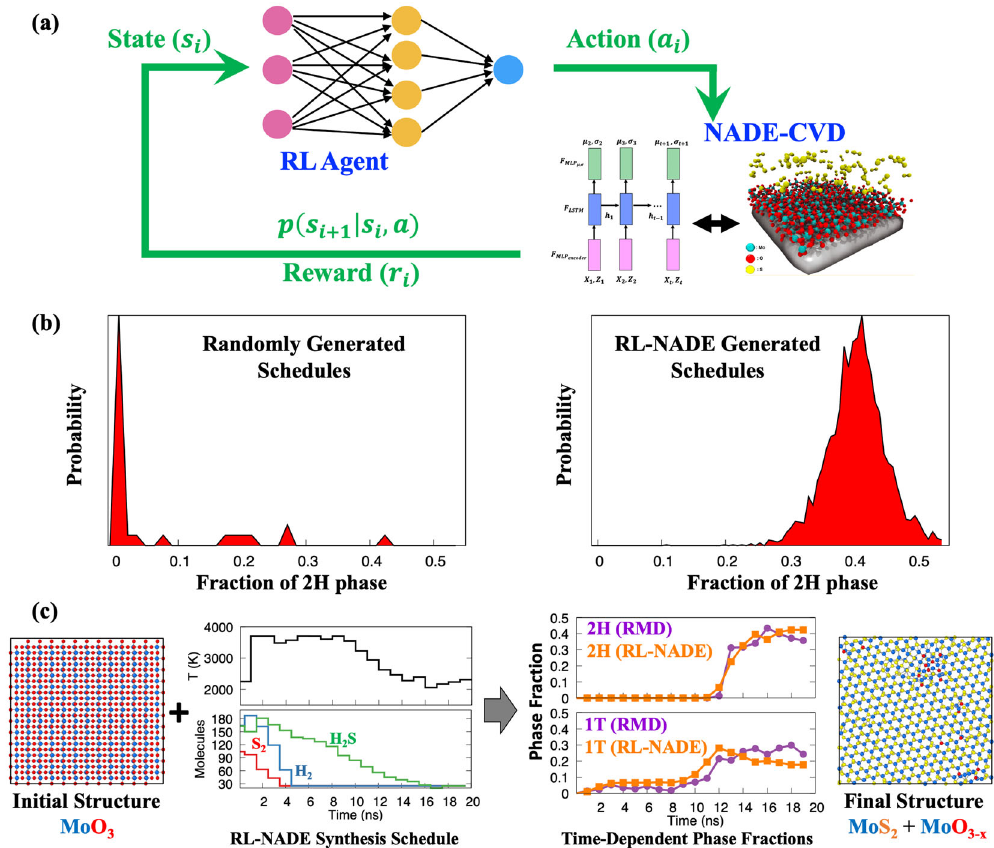
Fig. 3 Reinforcement Learning model for synthesis schedule design. a Schematic of the RL-NADE model for optimizing schedules for MoS 2 synthesis. b Comparison of structures generated by the RL-designed schedules against randomly generated schedules demonstrates that the RL-NADE model consistently identi fi es CVD synthesis schedules that generate highly crystalline products. c Validation of a promising RL- generated schedule using RMD